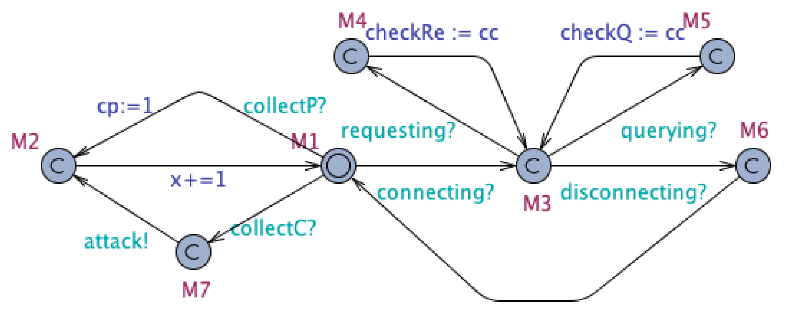
Figure 7. The malicious miner